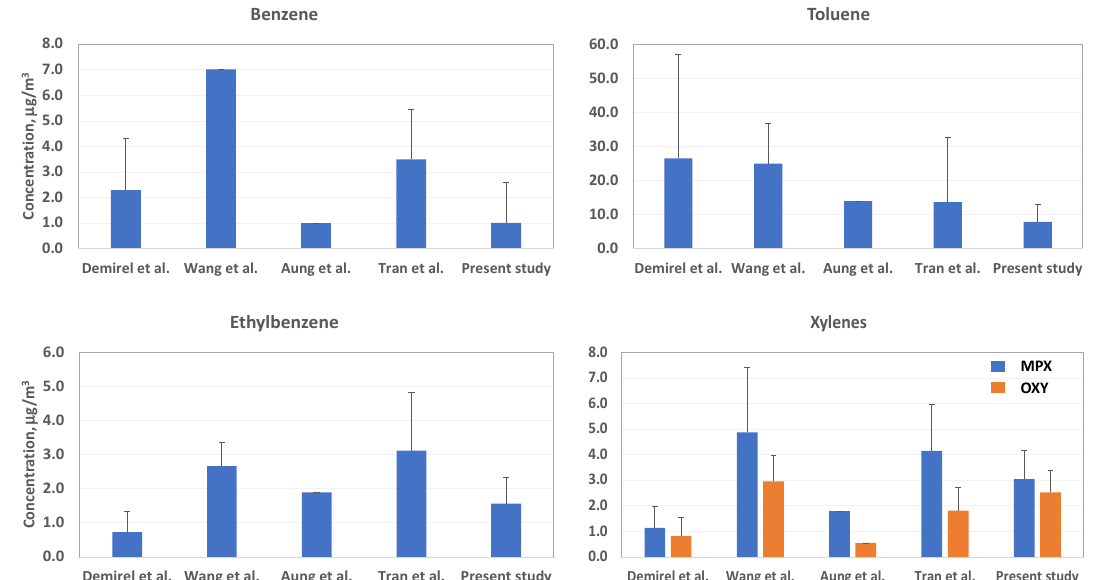
Figure 2. Comparison of mean BTEX levels among the studies in Asia. Error bars indicate standard deviation of the mean. Data from the prior studies [2,6,18,19] were used to construct the bar graphs.